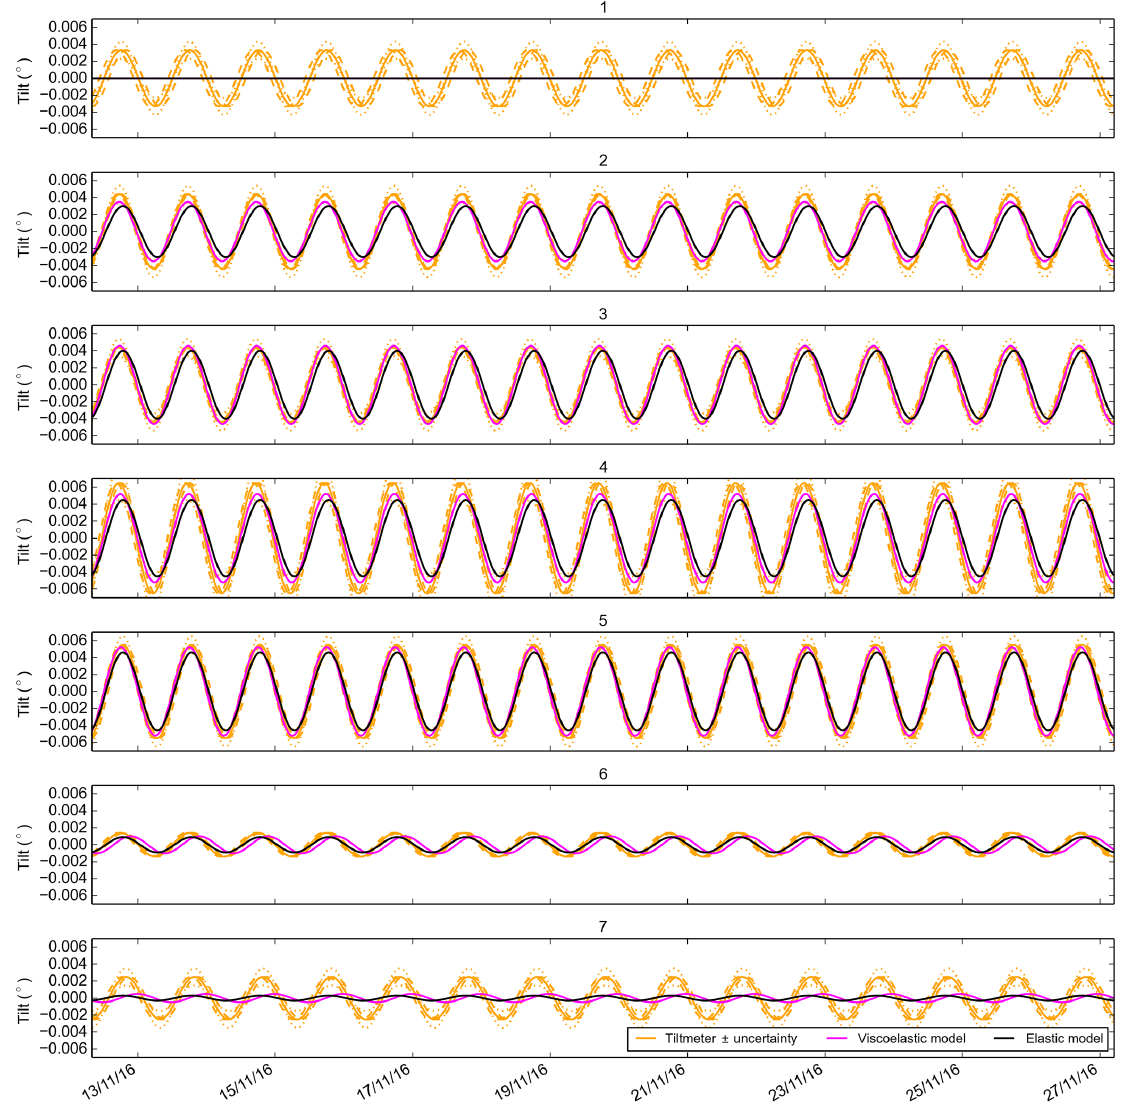
Figure 12. Surface flexure of the K 1 tidal constituent along the Darwin Glacier’s centerline as (orange) measured with an array of seven tiltmeters, (magenta) modelled using a viscoelastic rheology and (black) modelled with the elastic approximation. The orange dashed lines correspond to the uncertainty range of the K 1 phases as determined from harmonic analysis of the individual tiltmeter